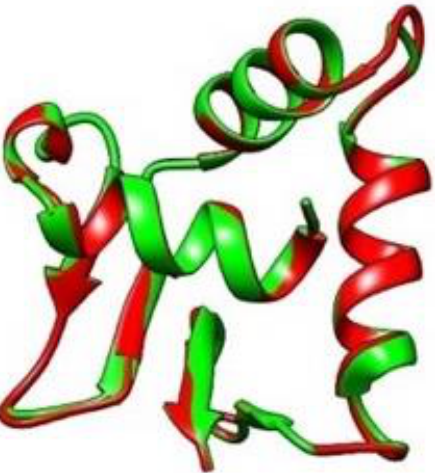
Figure 4. DNA binding domains of the wildtype and variant structures (green: wildtype; red: variant) were superimposed in UCSF Chimera and were found to be nearly identical (RMSD across all pairs: 0.058 Å ).